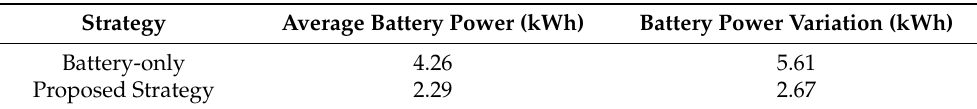
Figure 14. Discharging battery power comparison. Table 3. Performances